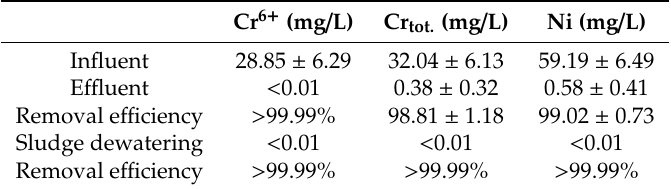
Table 5. Residual concentrations and removal e ffi ciencies of Ni and Cr in water streams.